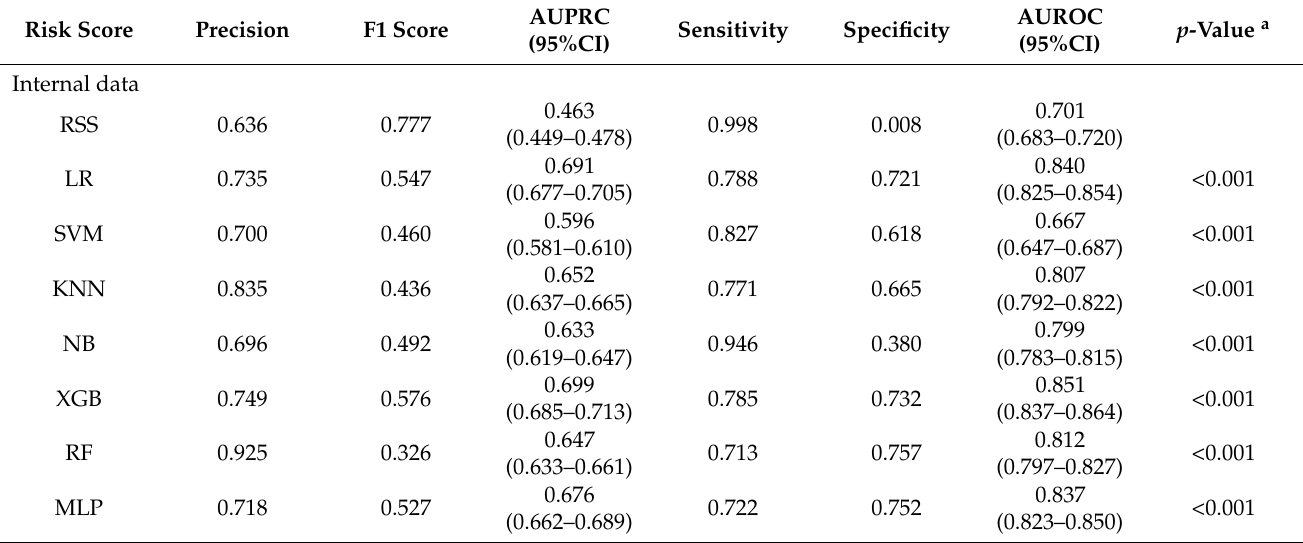
Table 3. Performance of the non-curative resection prediction model for the seven machine-learning models used in this study.